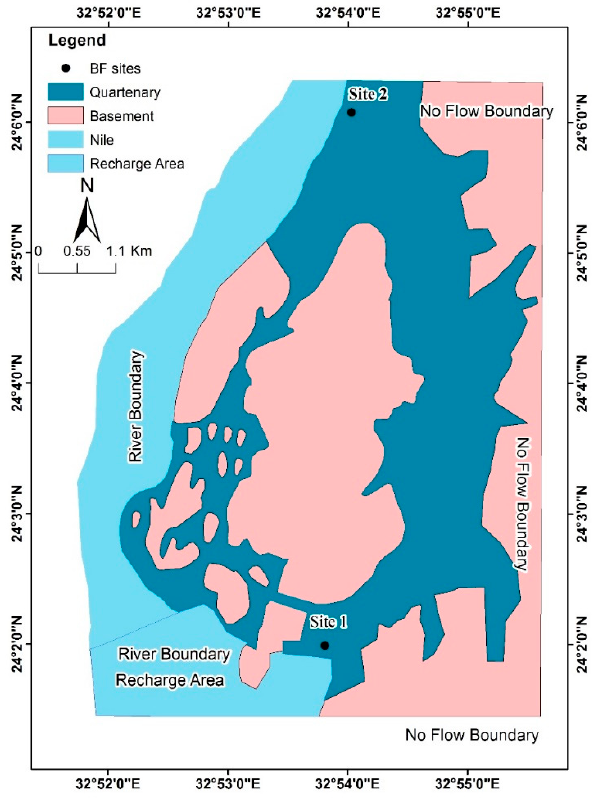
Figure 2. Geological units and model boundary conditions.